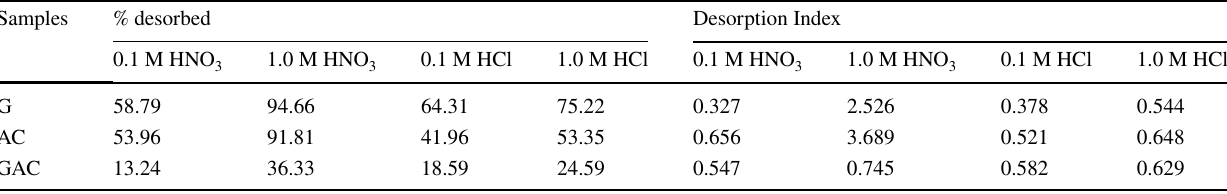
Table 5 Percentage desorbed and desorption index of Cr(VI) from G, AC and GAC Samples % desorbed